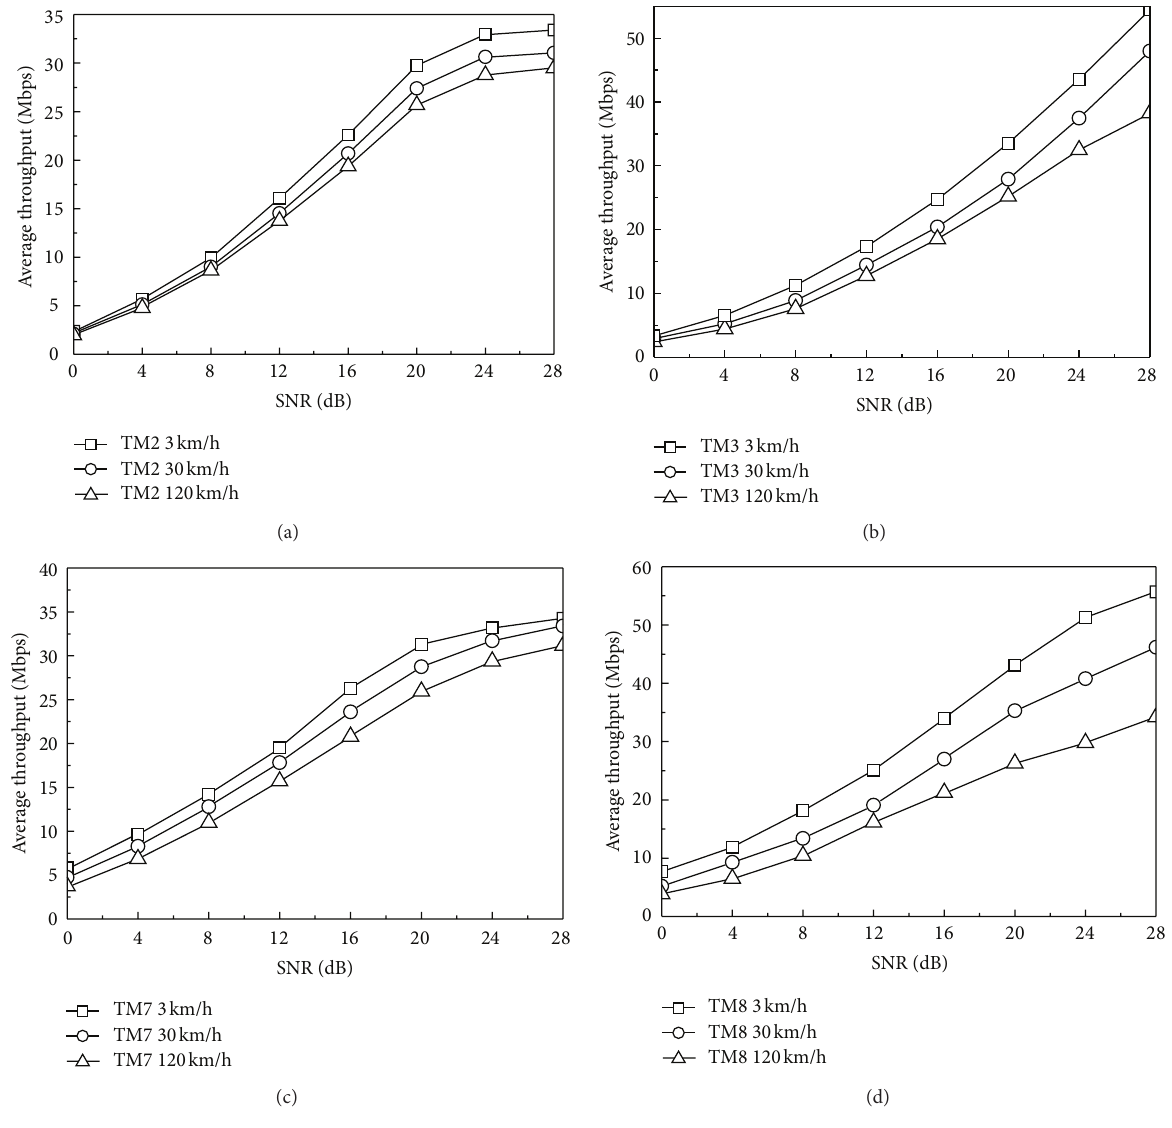
Figure 2: The downlink average throughput for SCME LOS.